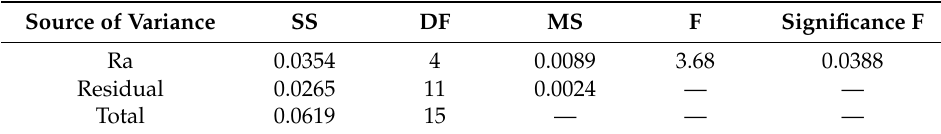
Table 8. Variance analysis of surface roughness (Ra).